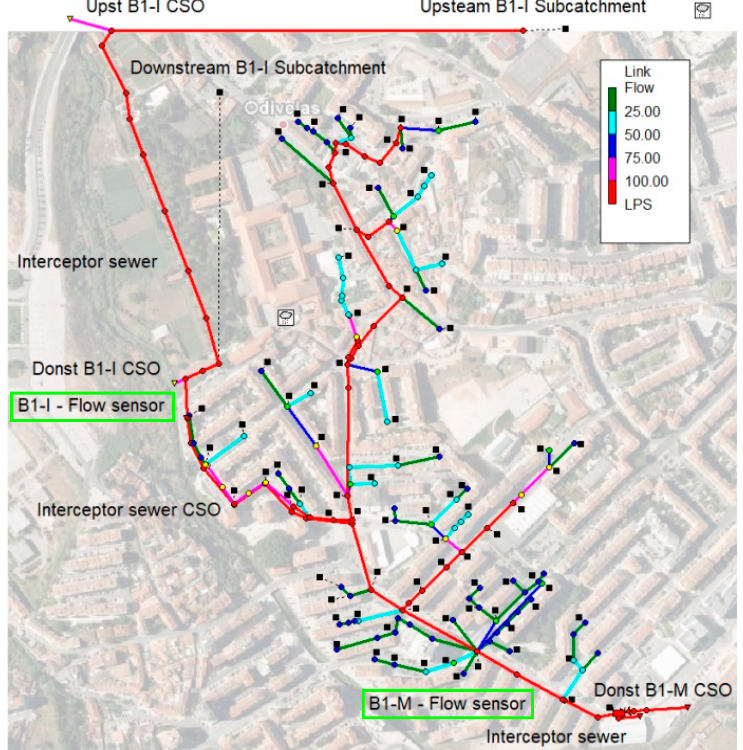
Figure 3. SWMM mathematical model and location of measurement sections.